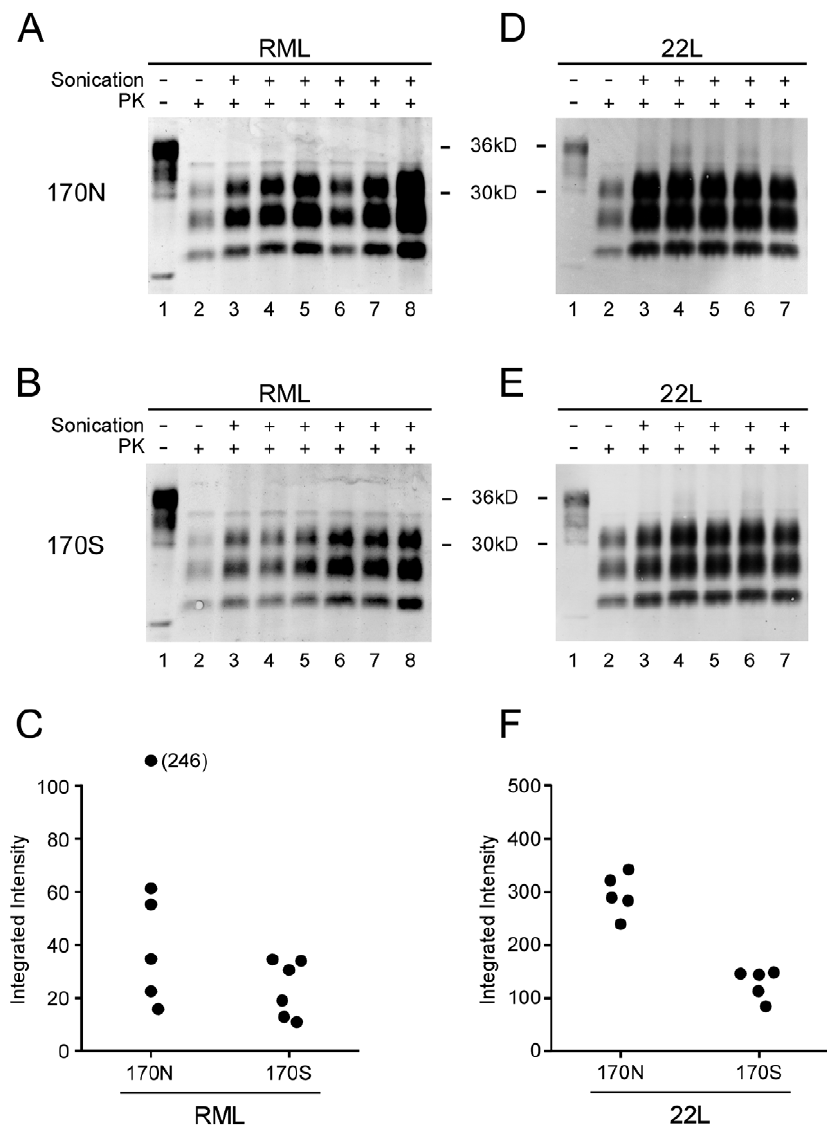
Figure 4. PMCA reactions comparing PrP-170N and PrP-170S as PrPsen substrates. Panels A, B, D, and E show immunoblots of PMCA products visualized on the LiCOR Odyssey Scanner. RML (A and B) or 22L (D and E) scrapie-infected brain homogenates diluted 1:400 were used to seed two different brain homogenate substrates: 170N from Tga20 mice (A and D) and 170S from Tg330 mice (B and E). For all gels, lane 1 contains unseeded Tga20 brain homogenate (5 m g brain equivalent of Tga20 brain homogenate), which was used as a control to show differences in detection sensitivity (gain setting) on the Odyssey scanner. For example, gain was increased for panels A and B compared to D and E because of the lower signal obtained with the RML seed in both 170N and 170S substrates. Other lanes contain 3.5 m l of PK-digested sonicated reaction product (lanes 3–8) or unsonicated freeze–control (lane 2). Amplification is evident by comparison of the unsonicated lanes with corresponding sonicated lanes. Results shown are representative of several independent experiments. Panels C and F show quantitation of PrPres as integrated intensity, i.e. the quantitative measure of protein detected by the scanner, from each lane of experiments shown in A, B, D, and E (using LyCor Odyssey scanner and software). Closed circles represent values for sonicated samples minus values for unsonicated freeze-control samples. Groups were compared by a 2-tailed nonparametric Mann Whitney test. For the 22L seed, the 170N and 170S substrates were significantly different (P , 0.01), and for the RML seed, the 170N and 170S were not significantly different